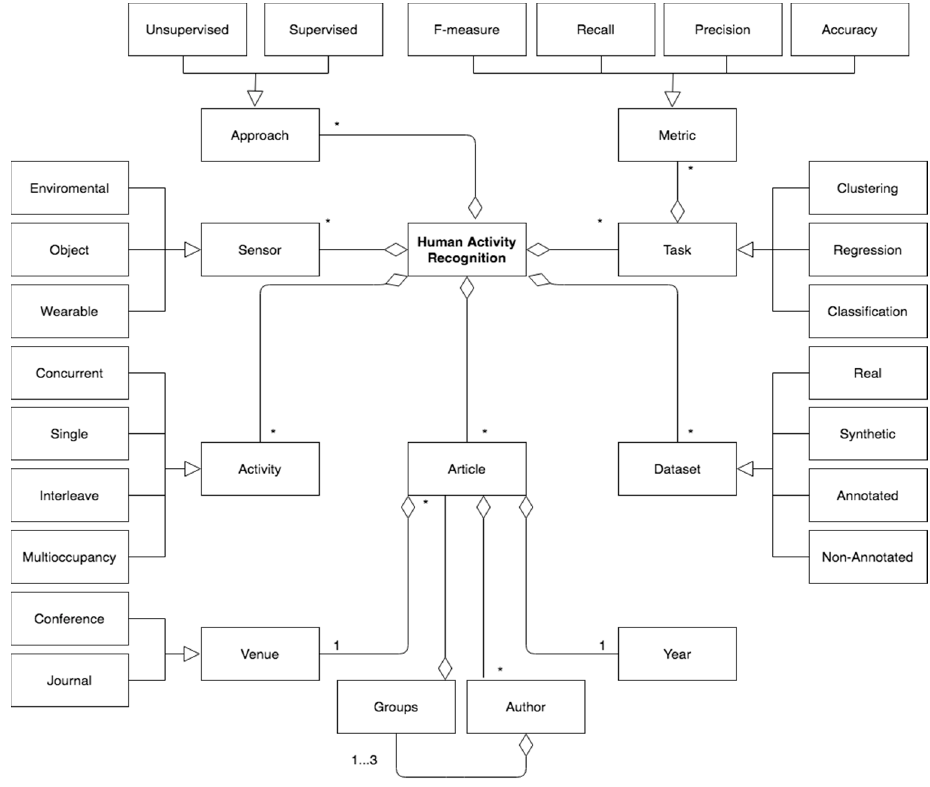
Figure 1. Conceptual model using UML Class Diagram formalism to represent the review of literature concepts.